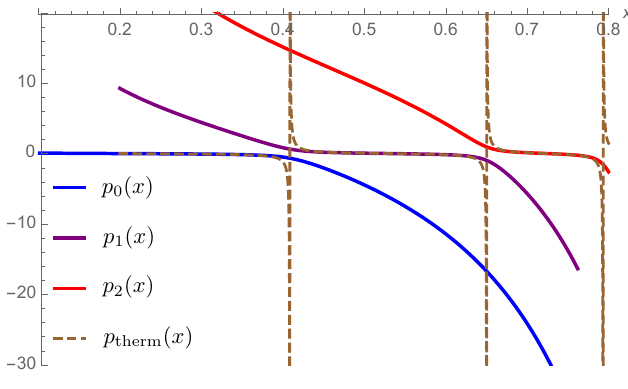
3 ) for the accessory parameter p Figure 2 . Solutions ( (cid:15) H = 36 ; (cid:15) L = 5 (cid:3) 10 (cid:0) (solid), compared against the leading order in ( (cid:15) L ) result p 0 ( x ) = p therm ( x ) that exhibits thermal O singularities.